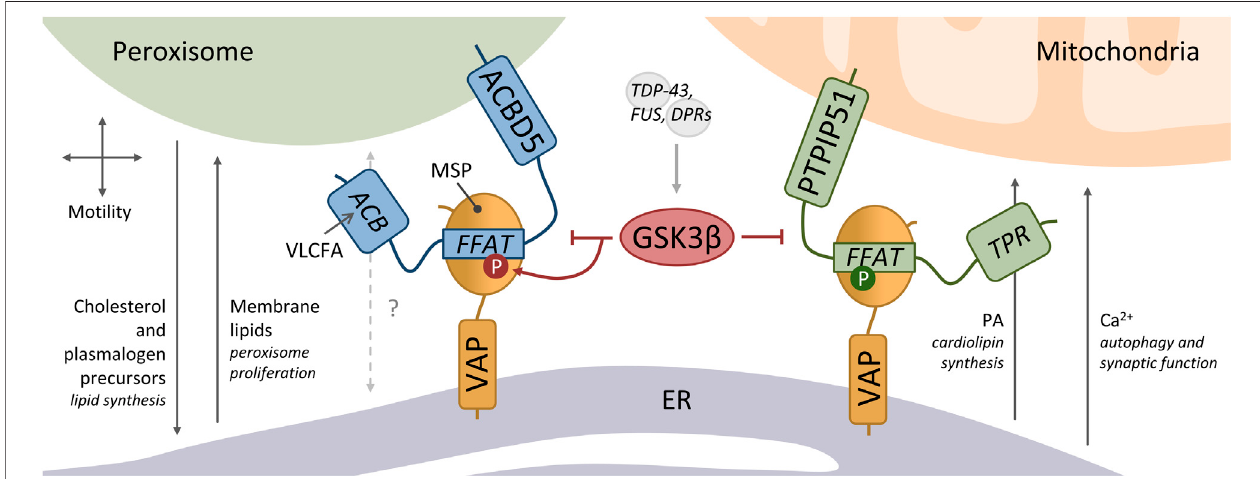
FIGURE 1 | Peroxisome-ER and mitochondria-ER membrane contacts tethered by VAP. ACBD5 interacts via its FFAT motif to the major sperm (MSP domain) of VAP to mediate peroxisome-ER contacts. These peroxisome-ER contacts have been implicated in peroxisome motility, the transfer of cholesterol and plasmalogen precursors for further synthesis in the ER, and the transfer of membrane lipids for peroxisome proliferation. ACBD5 has an acyl-CoA binding (ACB) domain which likely bindsverylongchainfattyacids(VLCFA).PTPIP51alsobindstotheVAP-MSPdomainviaaFFATmotif,whichmediatesmitochondria-ERcontacts.PTPIP51hasa tetratricopeptide repeat (TPR) domain with which it can bind and transfer phosphatidic acid (PA) to the mitochondria - required for the synthesis of cardiolipin. Ca 2+ uptake by mitochondria from ER stores at these contacts modulates autophagosome formation and synaptic activity. GSK3 β negatively regulates both peroxisome-ER and mitochondria-ER associations. GSK3 β acts on the ACBD5-VAP tether by directly phosphorylating the serine residue (S) at position 5 of the ACBD5 FFAT core ( 1 VYCDSME 7 ). GSK3 β can be activated by the ALS-associated proteins TDP-43, FUS and C9orf72-derived dipeptide repeat polypeptides (DPR). Phosphorylation of PTPIP51 at position 4 of the FFAT core ( 1 VYFTASS 7 ) is critical for binding to VAP.